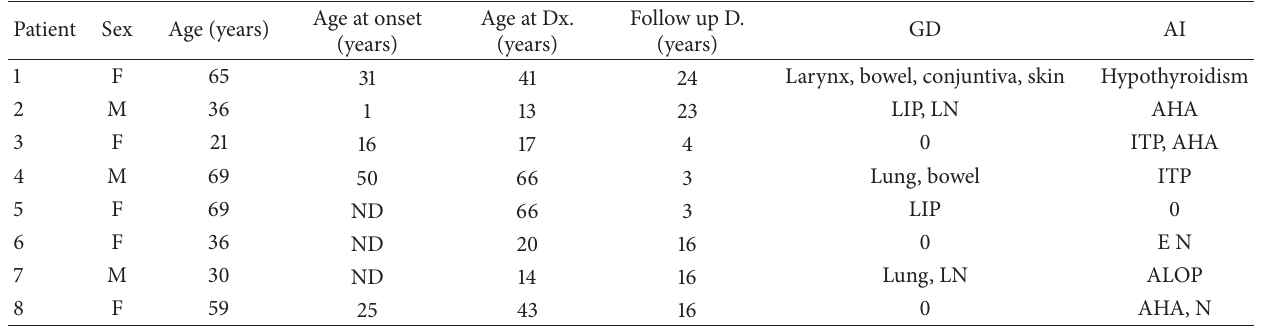
Table 1: Clinical and epidemiological data of Group I